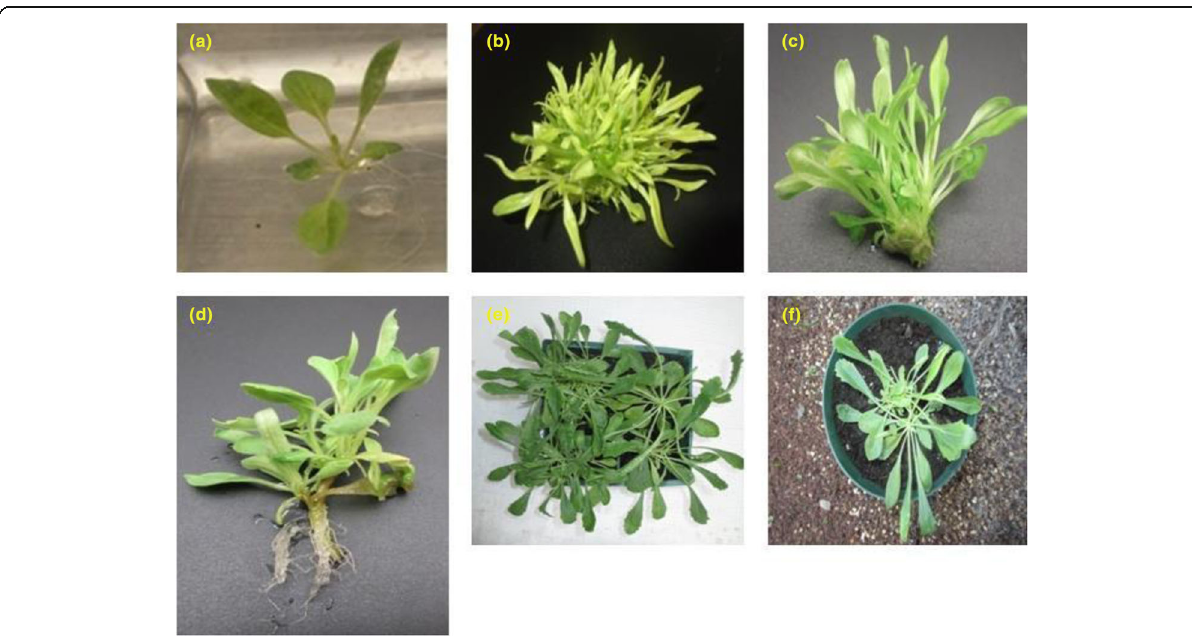
Fig. 3 Developmental stages of the in vitro propagation of Anarrhinum pubescens . A 4-week-old seedling ( a ), micropropagated shoots using BAP 1 mg/L + NAA 0.05 mg/L ( b ), organogenic shoots using BAP 0.05 mg/L + NAA 0.05 mg/L ( c ), rooted-shoots using MS-B 5 with 0.1 IAA mg/L ( d ), 10-week-old greenhouse-acclimatized plantlets ( e, f